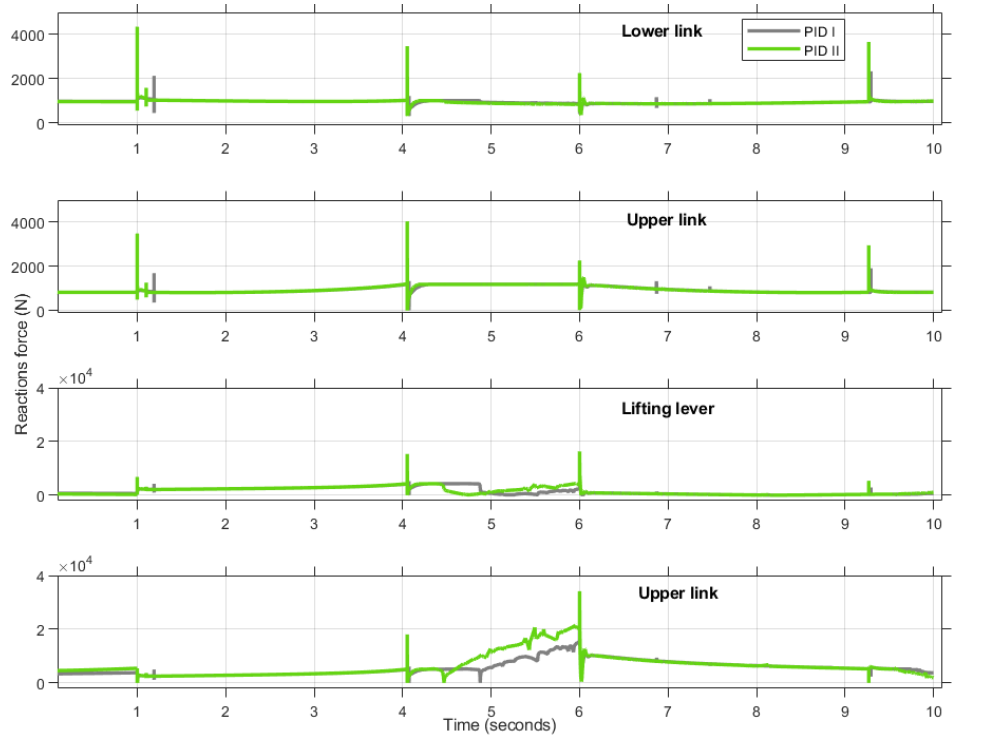
Figure 8. Correlation of the reaction forces determined with increasing dynamic friction